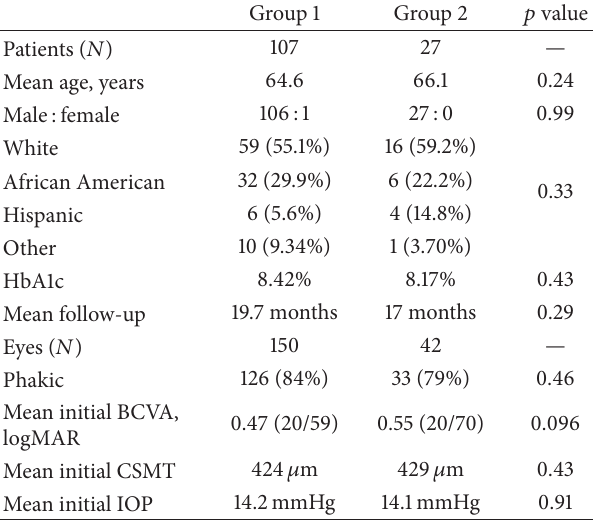
Table 1: Baseline demographic and ocular data.